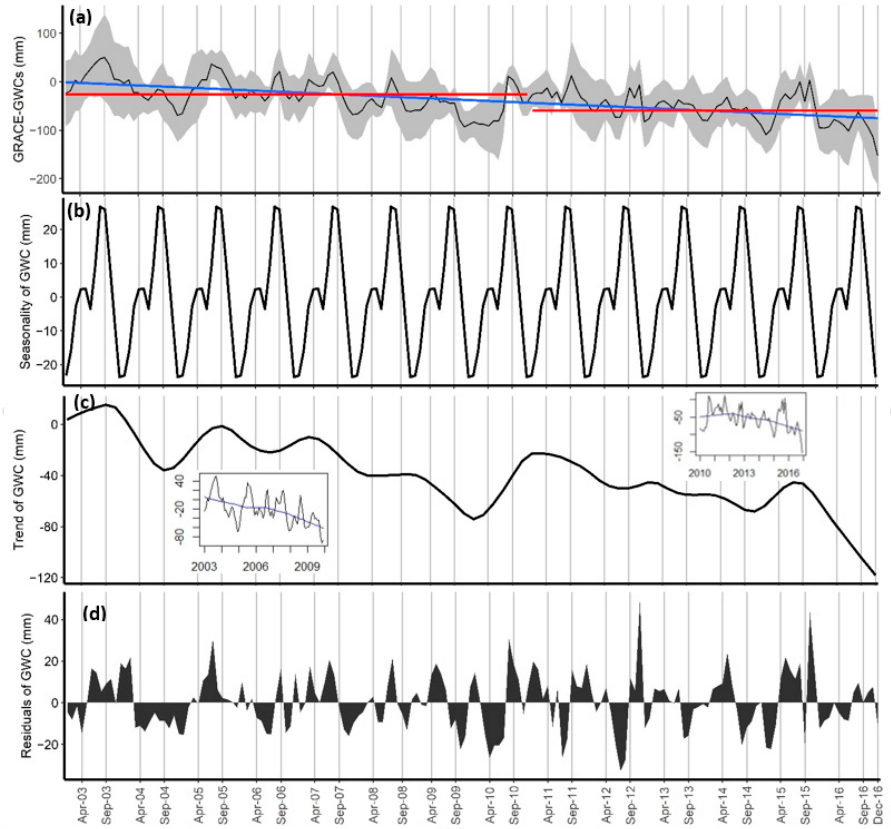
Figure 3. ( a ) GRACE-derived GWC time series, ( b ) seasonality, ( c ) trend, and ( d ) residuals of the decomposed GWC signals.